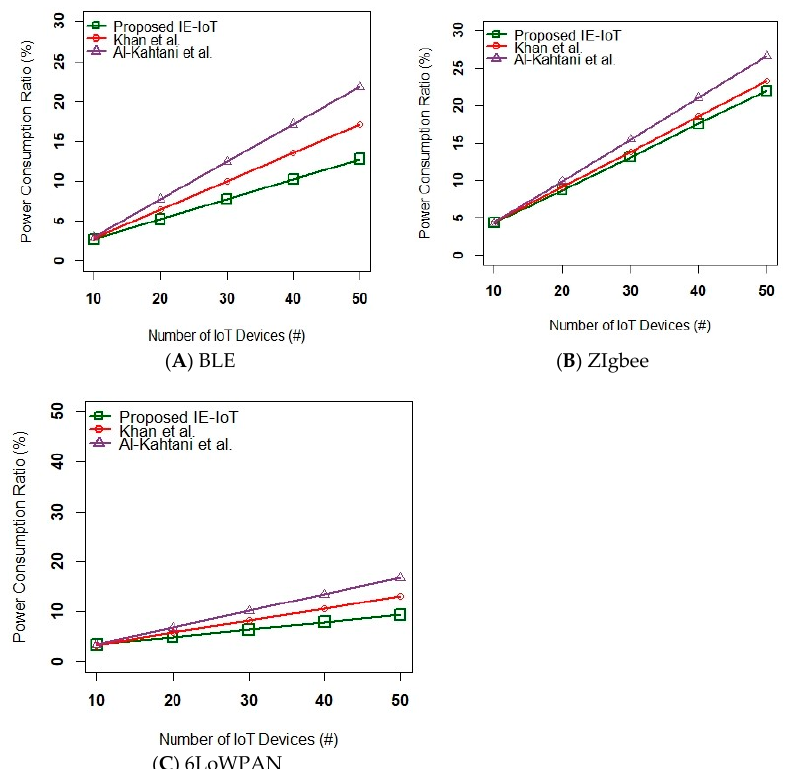
Figure 7. Power Consumption Ratio 〈%〉 versus Number of IoT Nodes. Figure 7. Power Consumption Ratio (cid:104) % (cid:105) versus Number of IoT Nodes